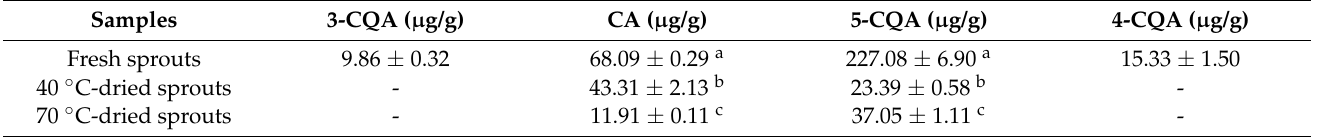
Table 2. Comparison of the phenolic acid content between fresh and oven-dried sprout samples. Results, reported as mean value ± standard deviation ( n = 3), are expressed on dry